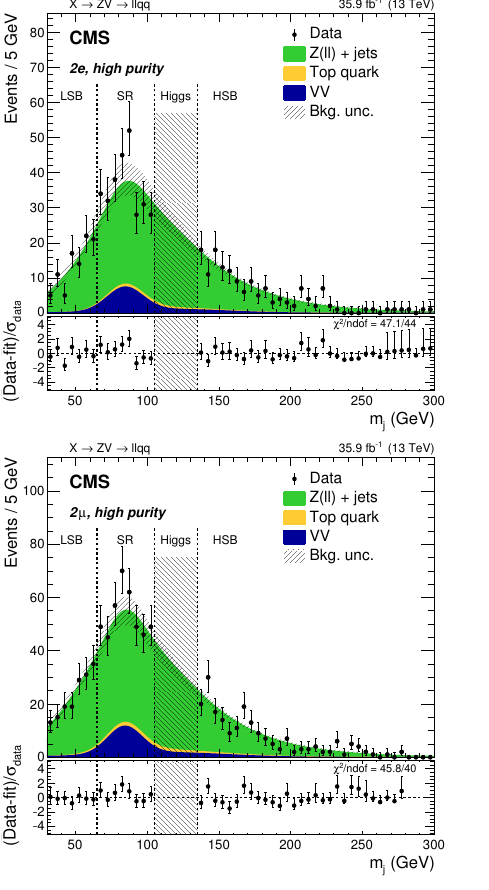
Figure 2 . The m j distributions of the events in data, compared to the expected background shape, for the high-mass analysis in the electron (upper) and muon (lower) channels, and for the high- purity (left) and low-purity (right) categories. The expected background shape is extracted from a (cid:12)t to the data sidebands (Z+jets) or derived from simulation (\top quark" and \VV"). The dashed region around the background sum represents the uncertainty in the Z + jets distribution, while the dashed vertical region (\Higgs") shows the expected SM Higgs boson mass range, excluded from the analysis. The bottom panels show the pull distribution between data and SM background expectation from the (cid:12)t, where (cid:27) data is the Poisson uncertainty in the